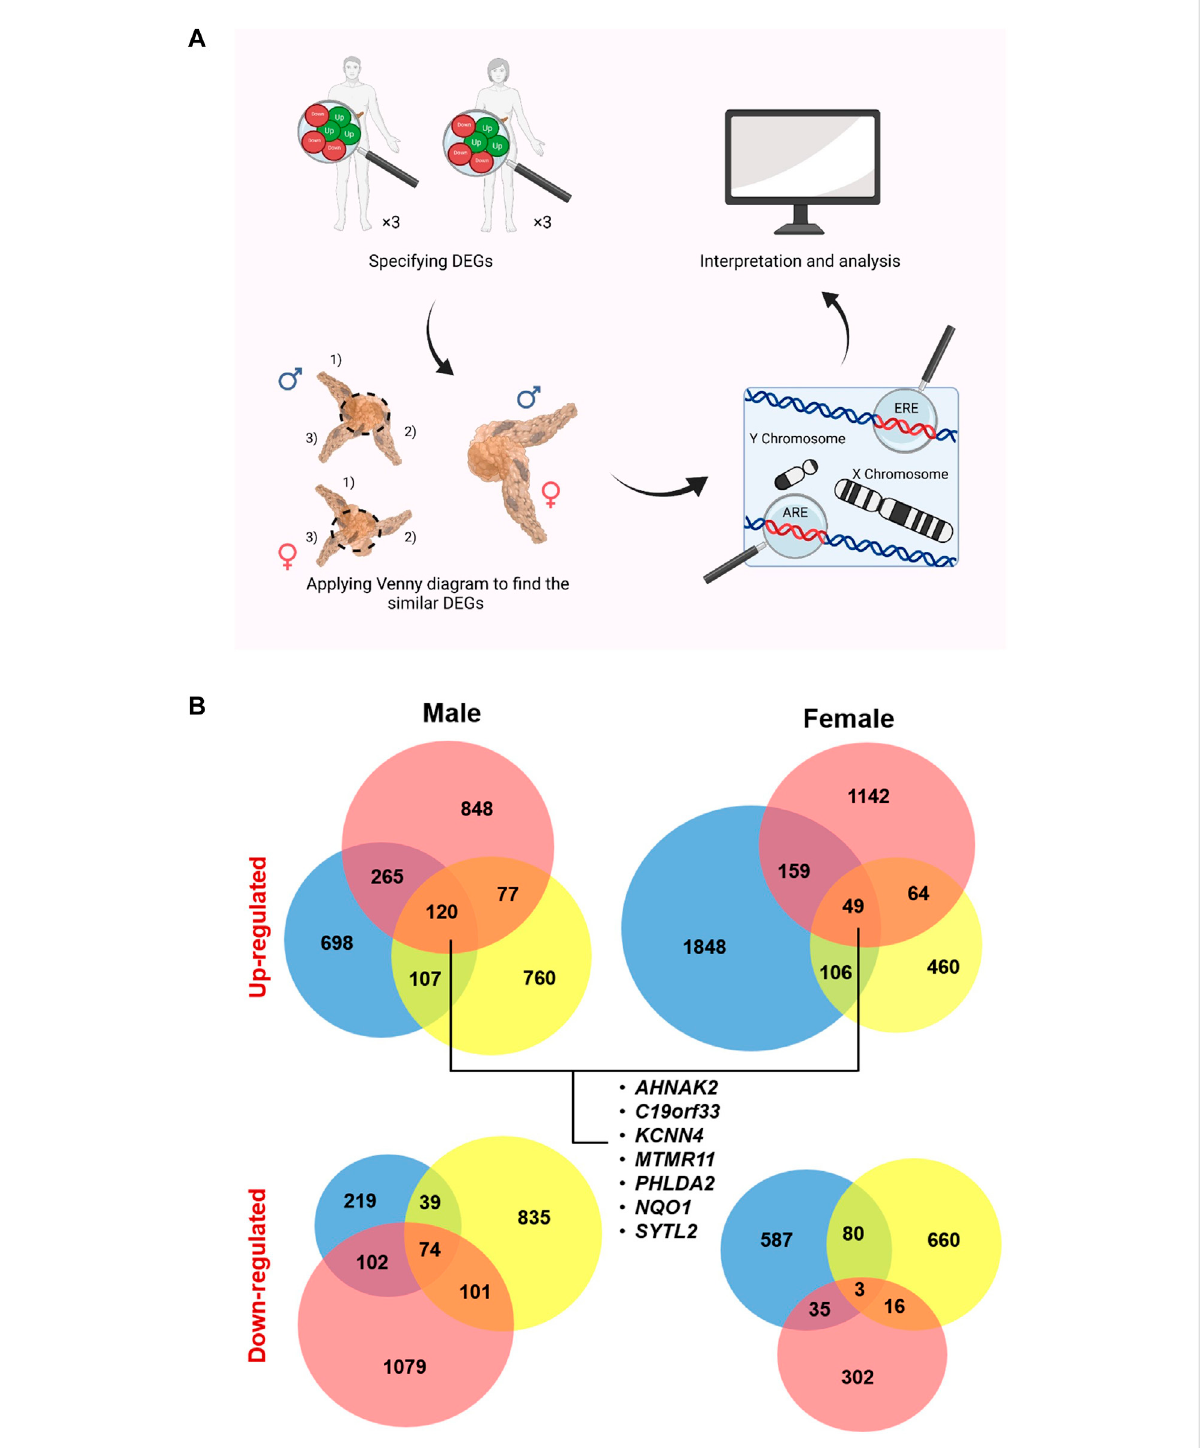
FIGURE 1 Study design and speci fi ed up- and down-regulated genes (U/DRGs). (A) Micro array studies for investigating the altered gene expression in both male and female pancreatic cancer (PC) patients were selected and the similar DEGs in both genders or thesex speci fi edDEGs were identi fi ed. Subsequently, genes with AREs or EREs, through performing functional enrichment analysis, and the ones located on sex chromosomes were speci fi ed. (B) The number of identi fi ed U/DRGs in both genders. Log FC value ≥ 1 or ≤ − 1 was chosen as the cut-off criterion for the up- and down-regulated genes, respectively, using a p-value of ≤